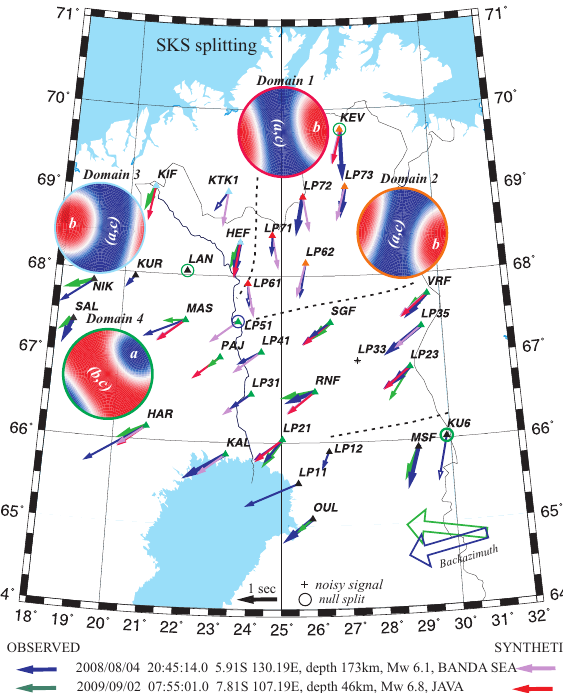
Fig. 4. Observed and synthetic shear-wave splitting for two events with easterly back-azimuths modelled according to results of the P-sphere inversions with modified inclination of symmetry axes (see Table 1). Stations (triangles) are coloured according to the anisotropic model used. Thick dashed lines delimit the domains whose structure is approximated by different models. Anisotropic aggregates with divergently dipping high-velocity (a,c) foliations (the b -axis models) approximate the lithosphere fabric beneath the northern part of the LAPNET array, whereas in the central part a model with steeply dipping lineation a (the a -axis model) fit the observed shear-wave splitting and P-wave anisotropic parameters (in its western part).